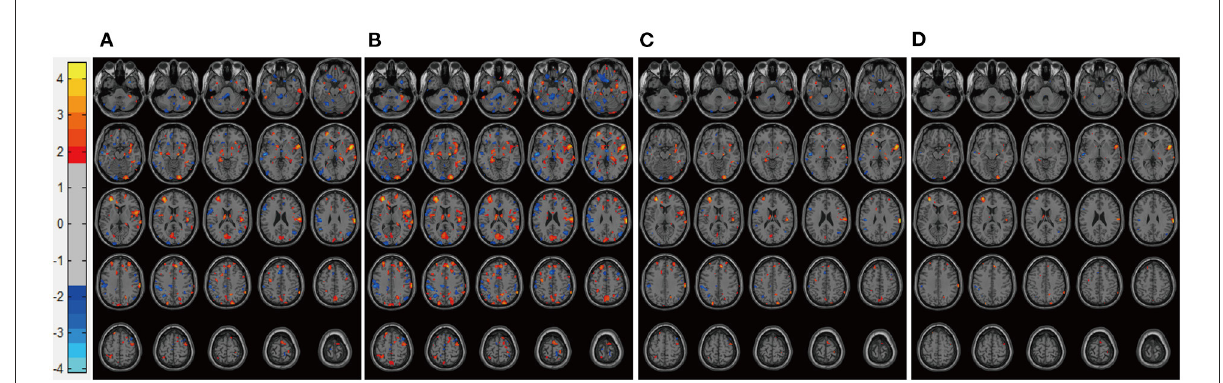
FIGURE2 Representative images of post-treatment rs-CBF in patients with BP experiencing their first depressive episodes. (A) DP/Li (B) DP/LTG, (C) DP/Li + LTG, and (D) DP/VPA + LTG. rs-CBF, resting-state cerebral blood flow; BP, bipolar disorder; DP, patients with BP experiencing their first depressive episodes; DP/Li, treatment with lithium; DP/LTG treatment with lamotrigine; DP/Li + LTG, treatment with lithium plus lamotrigine; DP/VPA + LTG, treatment with valproate plus lamotrigine.